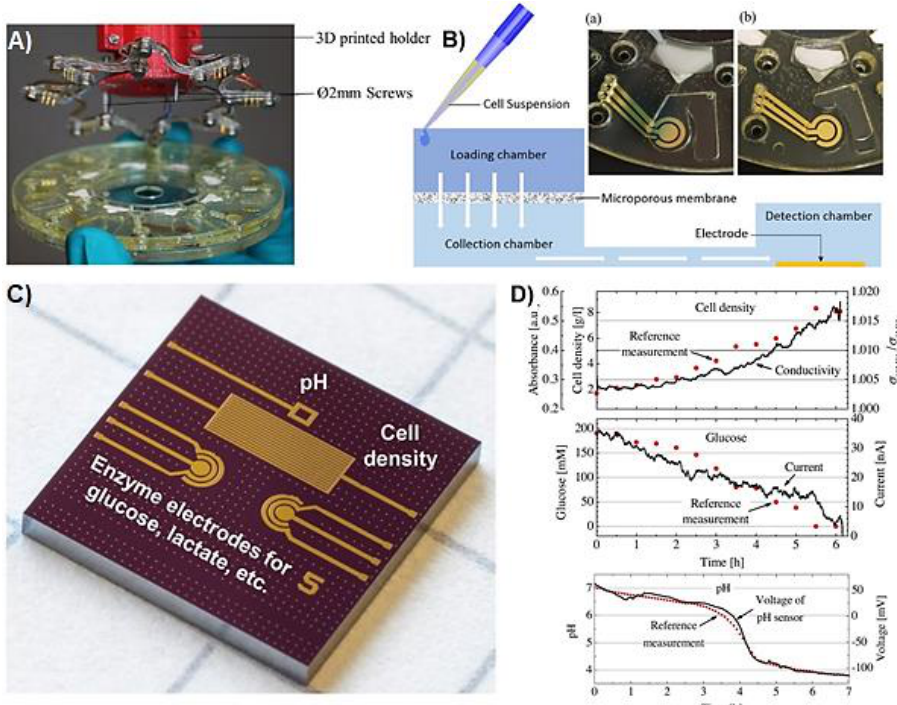
Figure 7. ( A ) The photograph of the microfluidic disc and printed circuit board with the magnetic clamping. ( B ) Schematics of the cross section of the microfluidic layout (the arrows show the flow direction during rotation): sample (a) before and (b) after on-disc filtration, reprinted from [106], with permission from Elsevier, copyright (2017). ( C ) The photograph of the integrated MEMS sensor chip with a size of 7.16 × 7.16 mm 2 . ( D ) Continuous bioprocess monitoring of cell density, glucose, and pH in a yeast culture, reprinted from [101], with permission from Elsevier, copyright (2016).